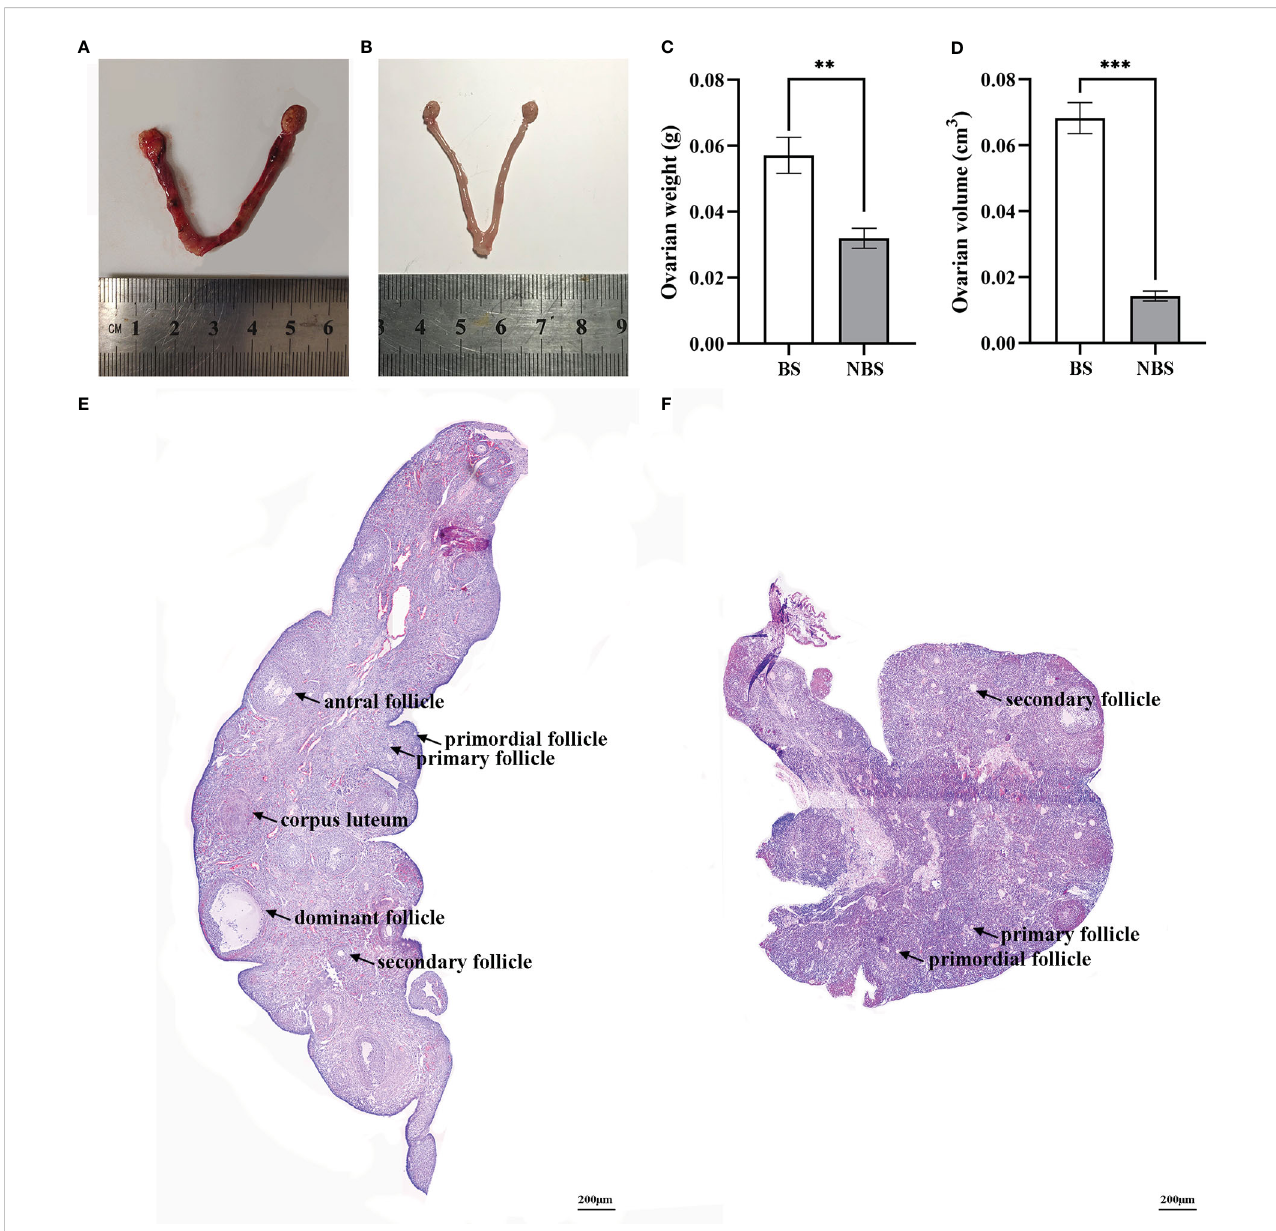
FIGURE 1 Morphological and histological features of ovarian tissues of the muskrats during the breeding and non-breeding seasons. The morphology of the ovaries and uterus of the muskrats during the breeding season (A) and non-breeding season (B) ; Marked seasonal differences were observed in ovarian weight (C) and volume (D) . HE staining was performed for the ovaries of the breeding season (E) and non-breeding season (F) . BS, breeding season; NBS, non-breeding season. Scale bars represent 200 m m (E, F) . *Statistically signi fi cant values (** P < 0.01, *** P <